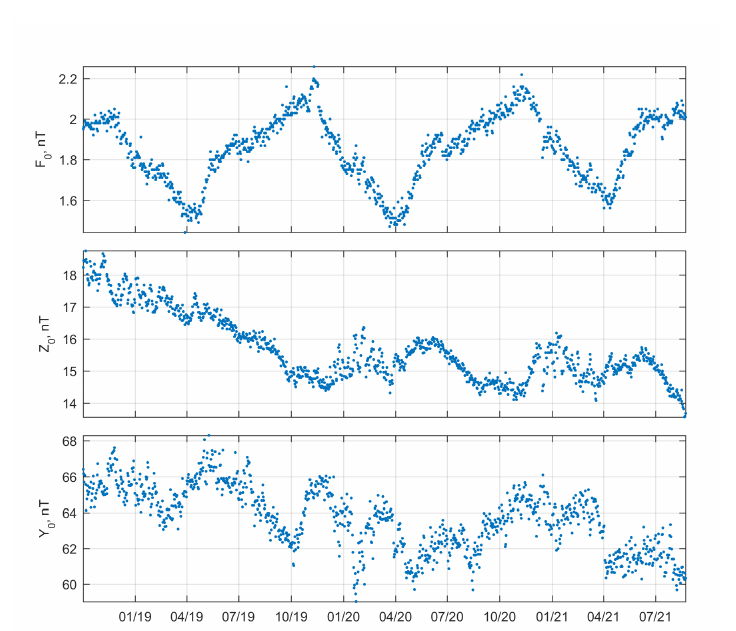
Figure 5. Daily mean baseline values of F 0 , Z 0 , Y 0 of the magnetometer POS-4 since October 2018.